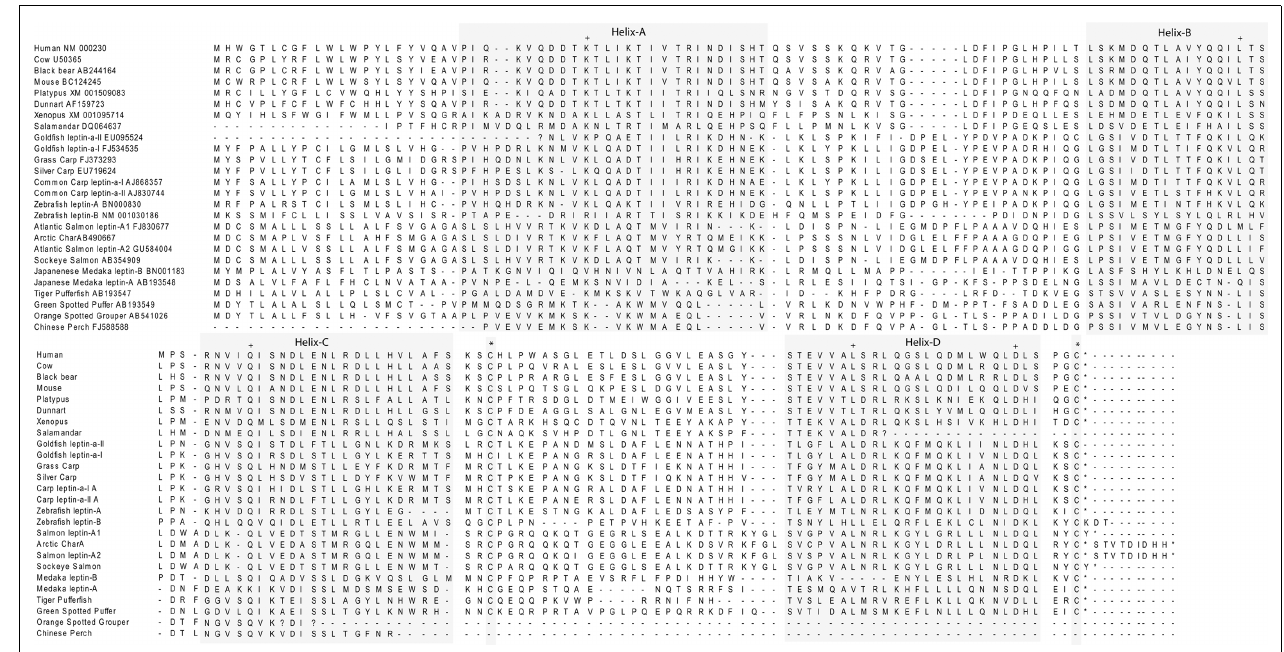
FIGURE 2 | Multiple sequence alignment of all fish leptin sequences entered in public databases, excluding duplicate sequences. Accession numbers are listed alongside taxa in the first row of sequence. Initial alignment of amino acid sequences was performed in ClustalW with